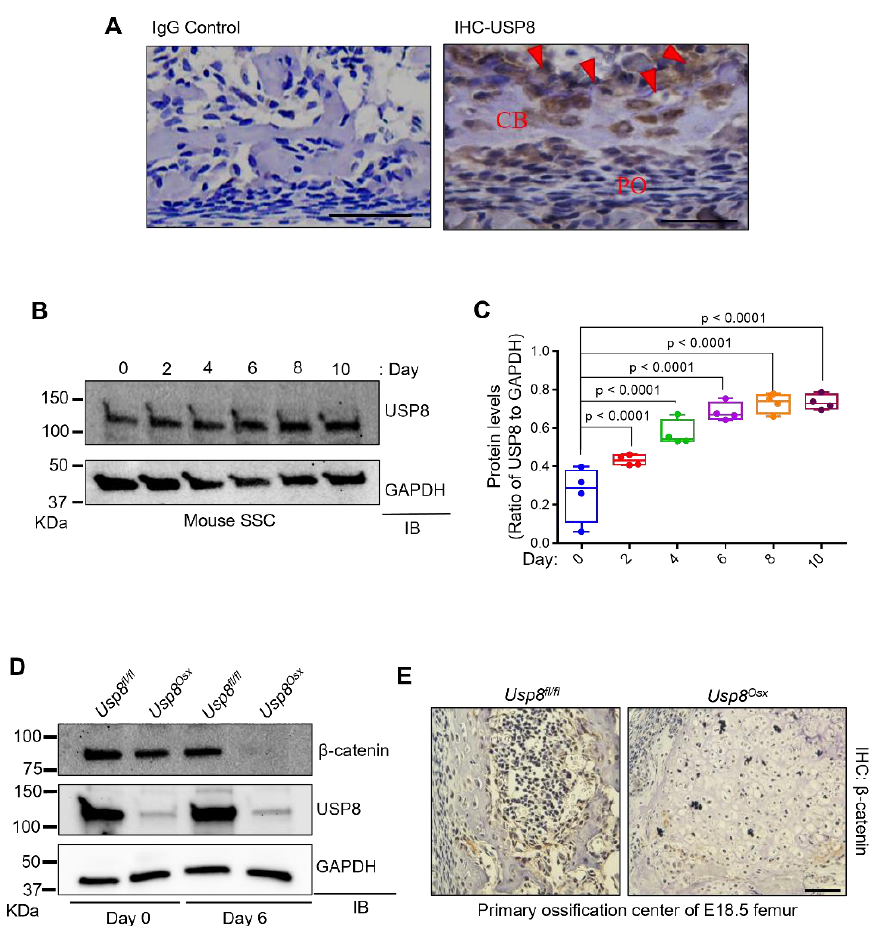
Figure 1. USP8 controls Wnt/ β –catenin signaling in osteoblasts. ( A ) Immunohistochemistry (IHC) for USP8 in mouse femurs at postnatal day 0 ( n = 3/group). Left, IgG control; right, IHC for USP8 in the cortical bone. CB, cortical bone; PO, periosteum. Arrows indicate bone-residing osteoblasts and osteocytes. Scale bar, 200 μ m. ( B , C ) Kinetics of USP8 expression during osteoblast differentiation. Skeletal stem cells (SSCs, CD45 − Ter119 − Tie2 − αVInt + Thy1 - CD105 - CD200 + ) isolated from E18.5 wild- type embryonic limbs were cultured under osteogenic condition, and USP8 expression was assessed by immunoblotting analysis. Protein levels of USP8 were displayed by the ratio of USP8 to GAPDH loading control ( n = 4). ( D ) Primary osteoblast precursors (COBs) isolated from the calvaria of P0 Usp8 fl/fl and Usp8 Osx neonates ( n = 5/group) were cultured under undifferentiated or osteogenic con- ditions for 6 days, and lysates were immunoblotted with the indicated antibodies. GAPDH was used as a loading control. ( E ) Immunohistochemistry for β– catenin in the primary ossification center of E18.5 Usp8 fl/fl and Usp8 Osx femurs ( n = 3/group). Scale bar, 100 µm. Data are shown as a box-and- whisker plot (with median and interquartile ranges) from min to max, with all data points shown. Statistical analysis was performed using an unpaired Student’s t – test within Prism.